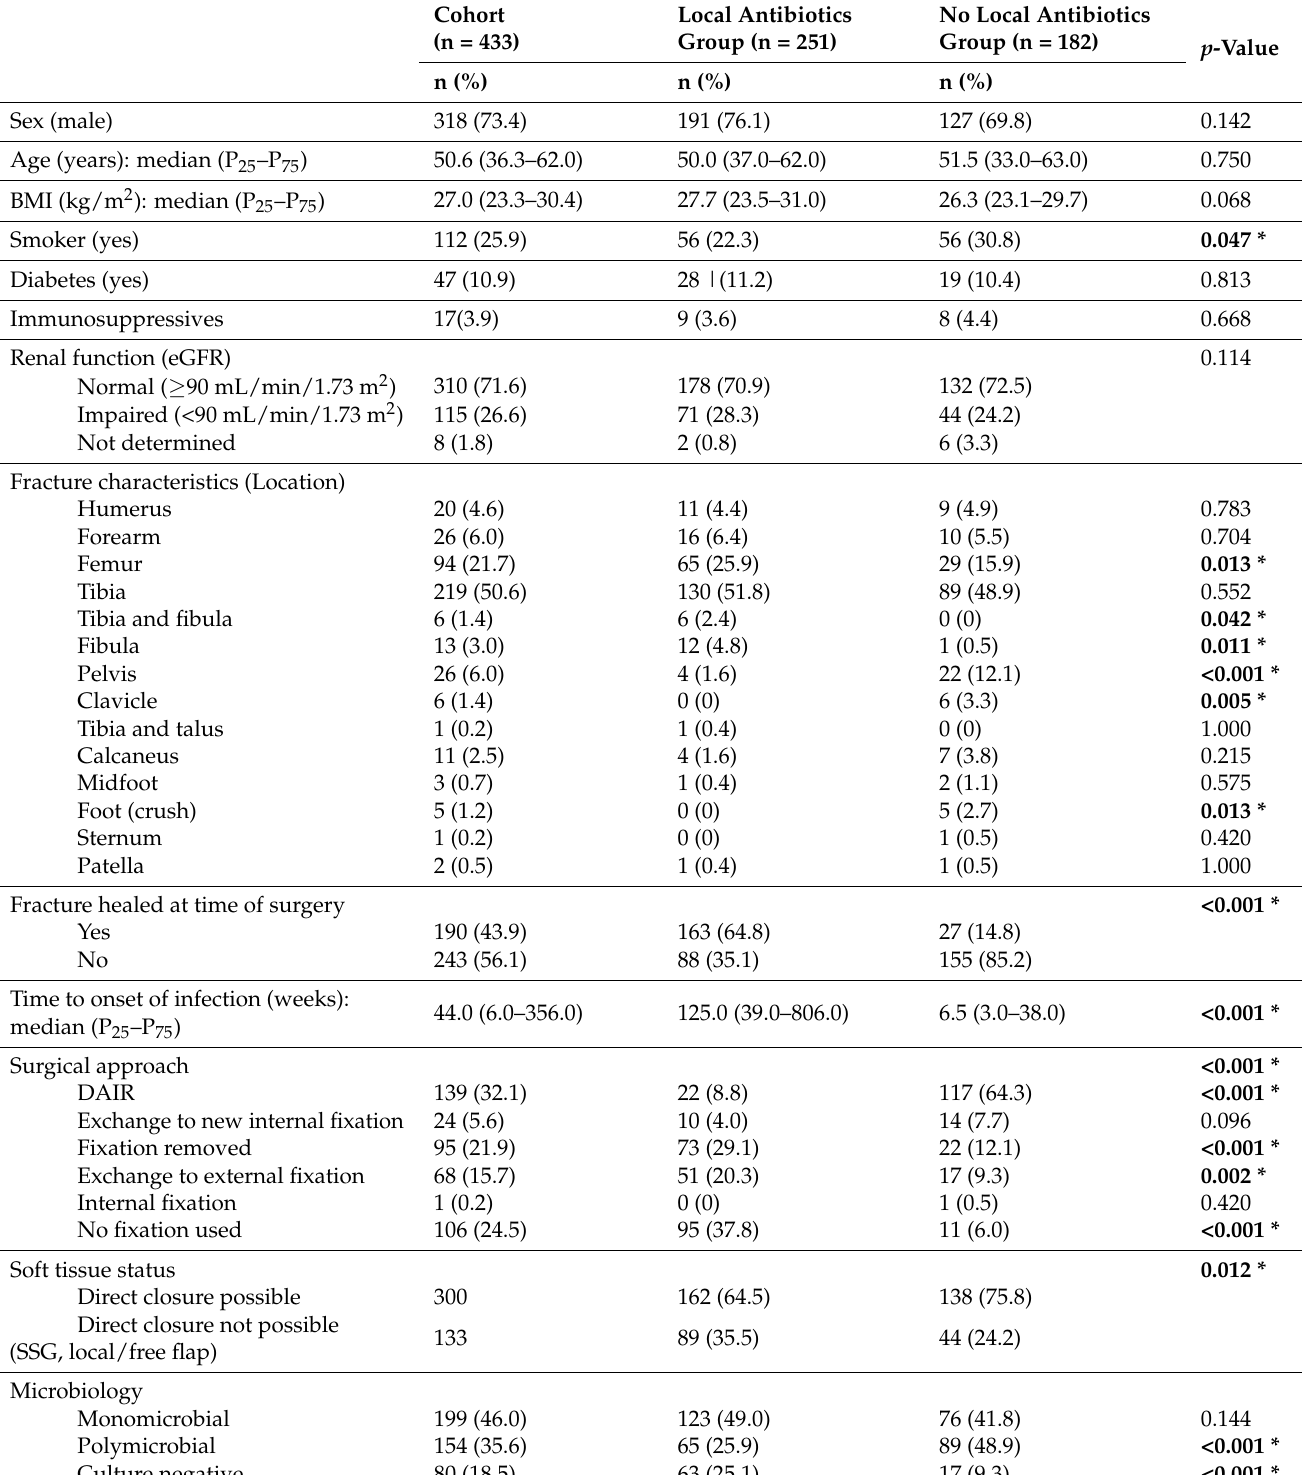
Table 1. Baseline patient